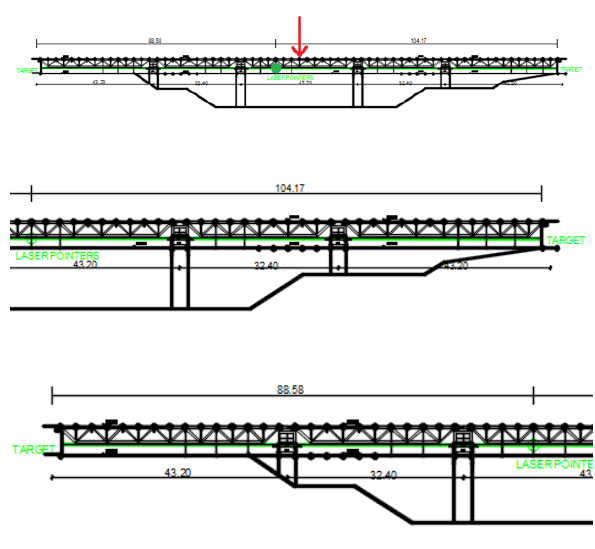
Figure 5. Test layout (top). Enlargement of the north (central panel) and of the south stretch (lower panel).